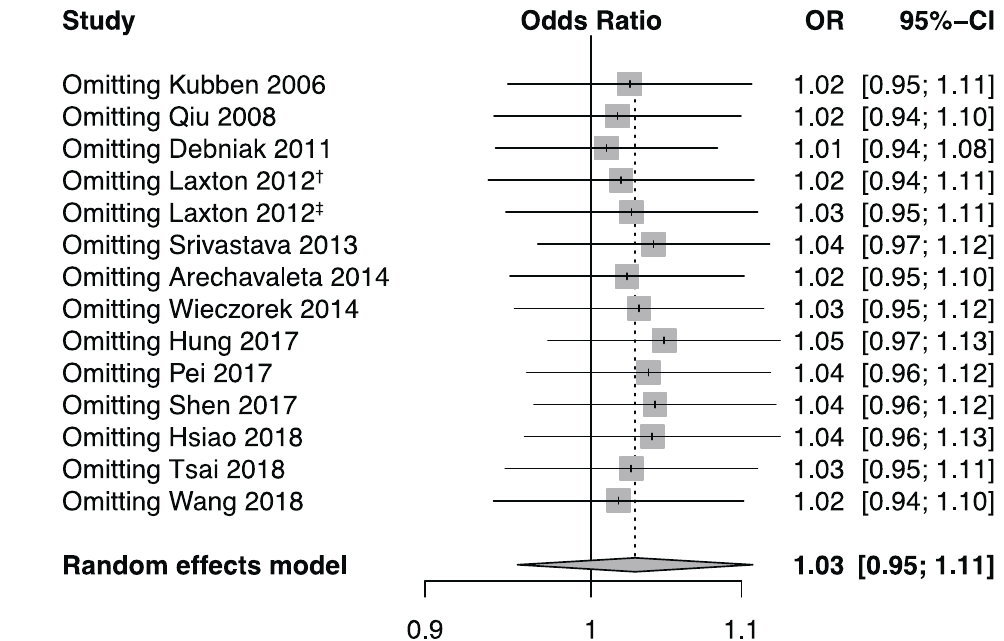
Figure 5. Forest plot for sensitivity analysis under the allele model. Pooled estimates were calculated using the random effects model. The named study was omitted to reappraise the association between the MMP-8 rs11225395 polymorphism and cancer risk. † marks the population of the United Kingdom in Laxton’s study (2012), and ‡ marks the population of Poland in Laxton’s study (2012).